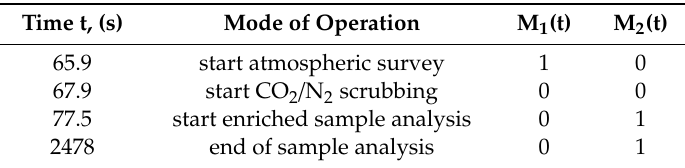
Table 4. State logic for Mindrum micro